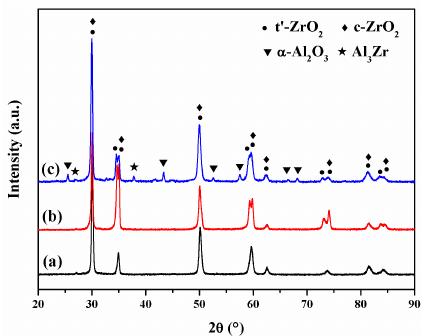
Figure 8. XRD patterns of ( a ) plasma-sprayed, ( b ) dotted, and ( c ) DA coatings before the hot corrosion test at the 2 θ range of 20°–90°.